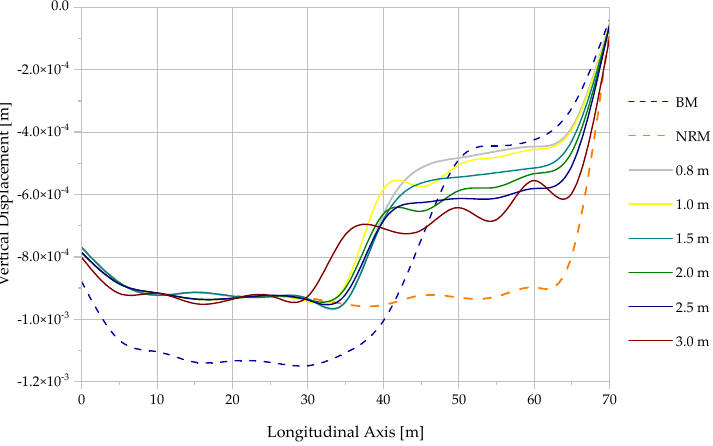
Figure 9. Vertical displacements when implementing the